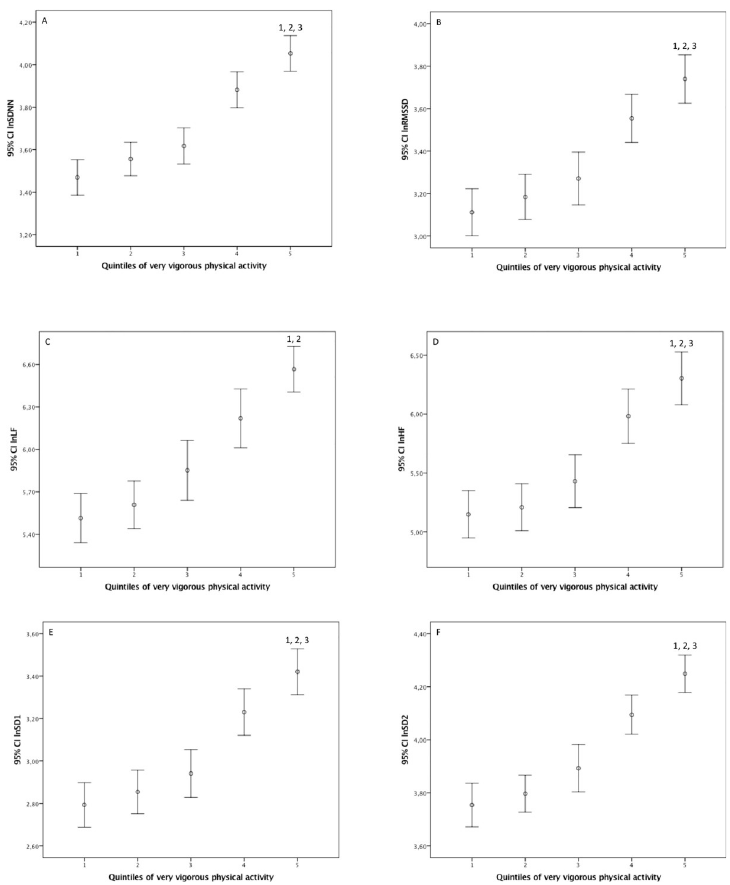
Fig 3. Results of the multivariate analysis of covariance (ANCOVA) with the differences between the very vigorous physical activity quintiles in min/week for the heart rate variability normalized utilizing logarithmic transformations (group 1, � 1.50; 2, 1.51–3.16; 3, 3.17–3.54; 4, 3.55–20.75; and 5, > 20.75). SDNN (A): the standard deviation of the RR intervals; RMSSD (B): root mean square of RR intervals; LF (C) and HF (D): respectively powers of the low- and high-frequency bands; SD1 (E) and SD2 (F): respectively perpendicular and along with regression line of the Poincare´ plot standard